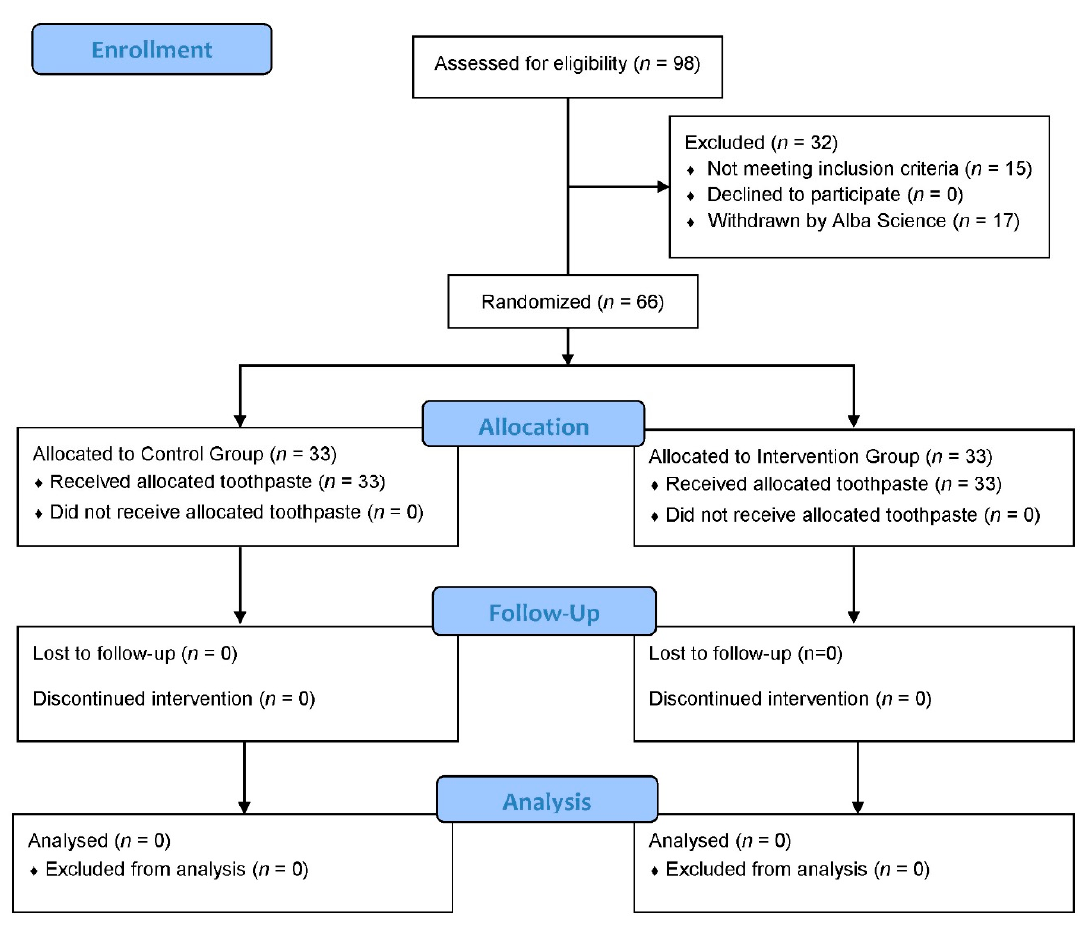
Figure 1. Flow Figure 1. Flow diagram.